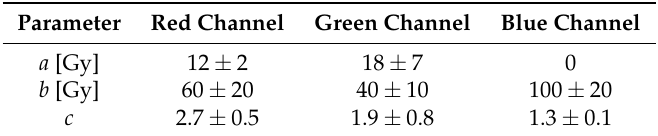
Figure 6. EBT3 calibration curves for two incident proton energies. The lines represent a fit to the two data sets, for each one of the colour channels. Table 3. Results obtained for the parameters of Equation (4) from the fit of the data in Figure 6 for the three colour channels. For the blue channel, parameter a has been fixed equal to